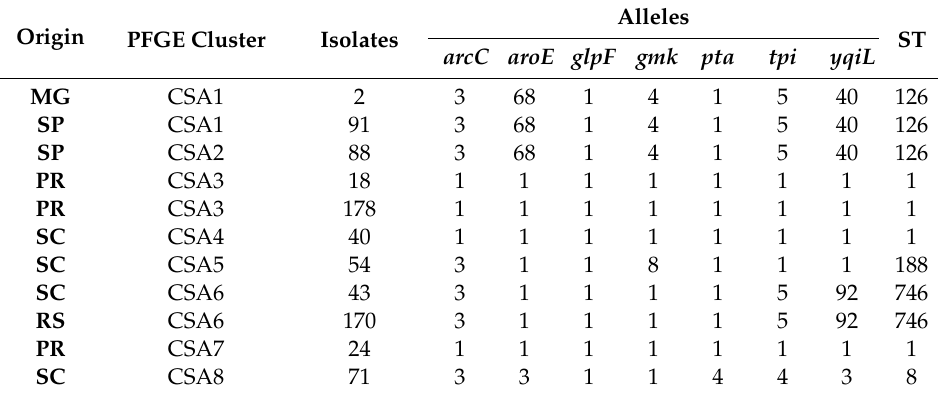
Table 4. Identification of the sequence type (ST) of Staphylococcus aureus isolates.